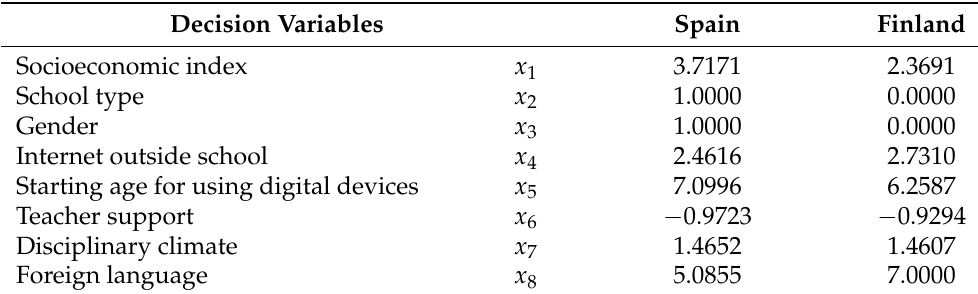
Table 13. Pareto optimal solutions obtained to the deterministic problems for Spain and Finland.